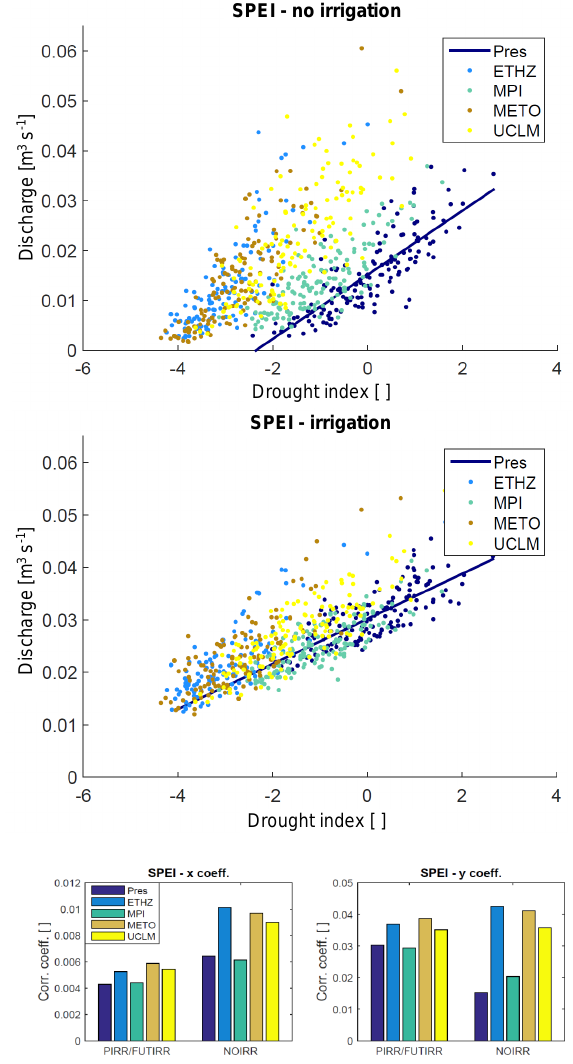
Figure 6. Performance of SPEI in future climate for annual dis- charge. The blue line is the linear regression between SPEI and dis- charge in present climate. Top panel: NOIRR scenario, large model bias. Second panel: FUTIRR scenario, no significant model bias. Bottom panel: the two coefficients of the linear regression between Q and SPEI in each